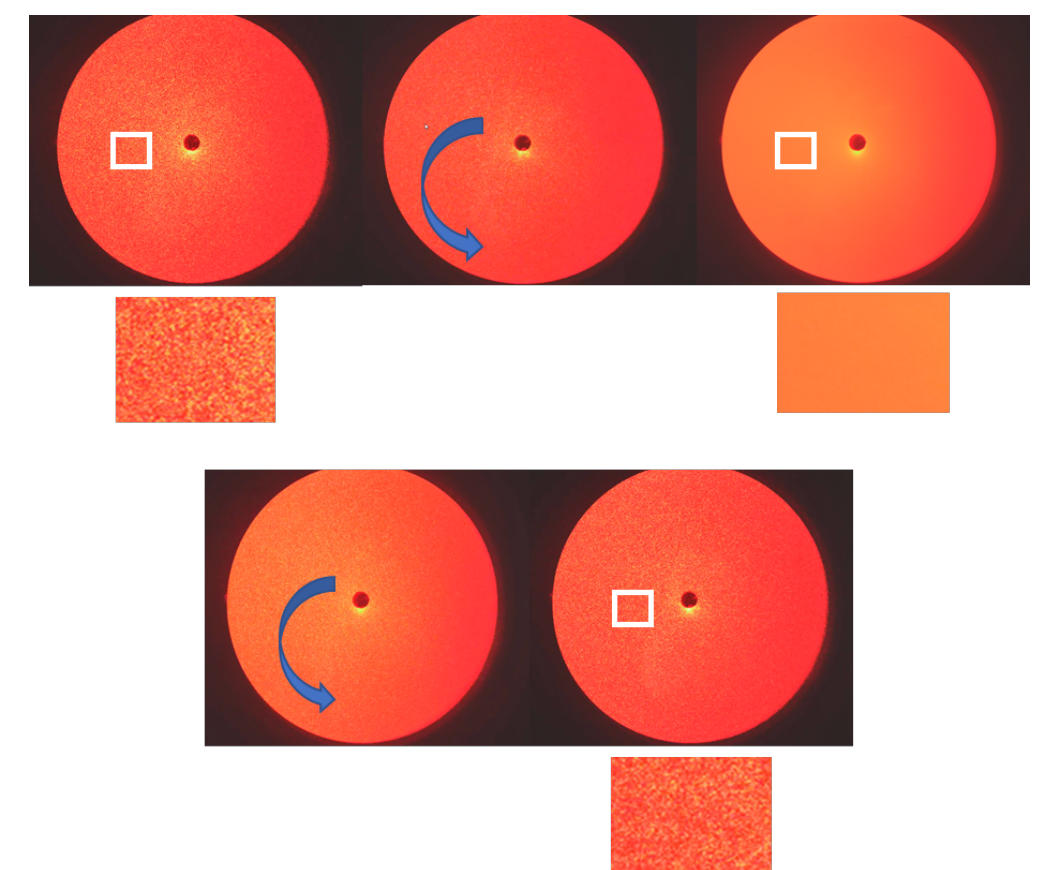
Figure 13: Treated SA GCC in hexadecane 3 w/w% solids under shear between parallel counter-rotating plates, gap 0.3 mm: left to right low shear under ramp-up, stochastic transition via partial total rotation as shear increases (indicated by the arrow), high shear, re-occurrence of stochastic total structure rotation transition (indicated by the arrow), and low shear under ramp-down. Enlarged images from the rectan- gular inserts reveal the structural change from remaining static despite shear, to homogeneous shearing and return to a structured state despite continuing low shear,